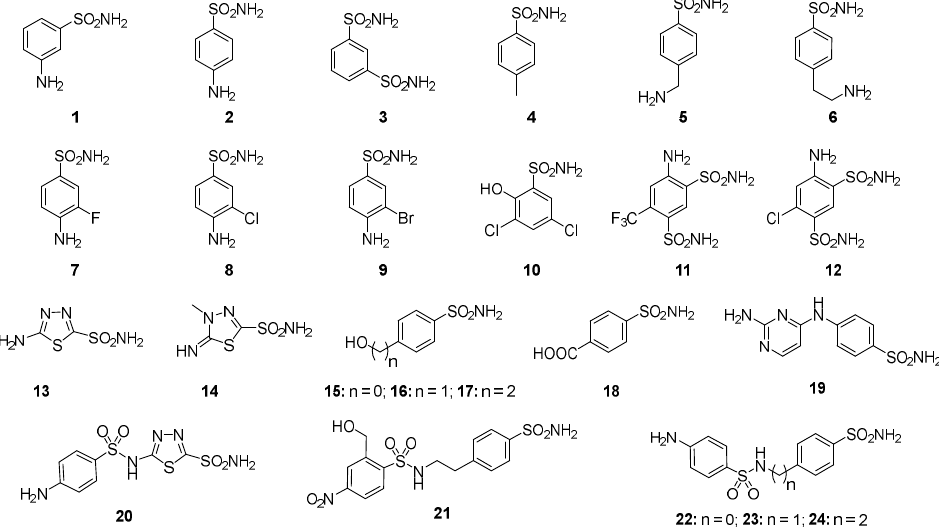
Figure 4. Structure of commercially available sulfonamide derivatives 1–24 .